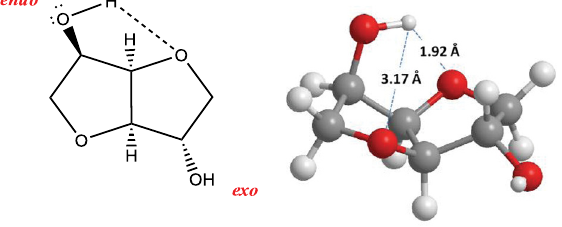
Figure 2. Con fi guration of the two hydroxyl groups into the iso- sorbide